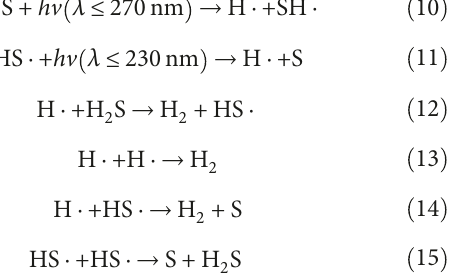
Figure 6: The relationship between H retention time of direct photolysis by UV with the absence of